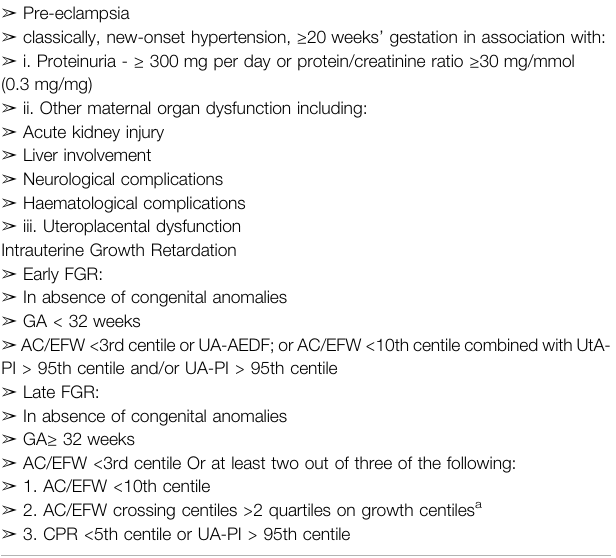
TABLE 1 | Clinical categories and characteristics of pre-eclampsia and foetal growth